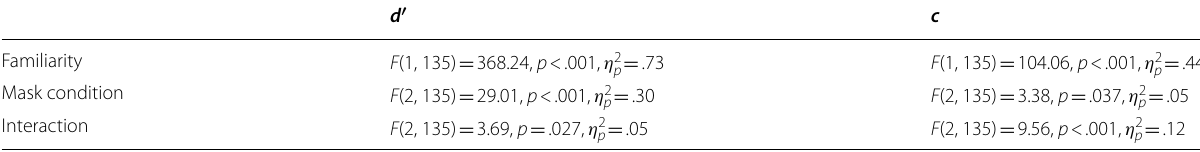
Table 4 Separate repeated-measures ANOVAs for measures of human performance (d ′ , c) on the SFMT